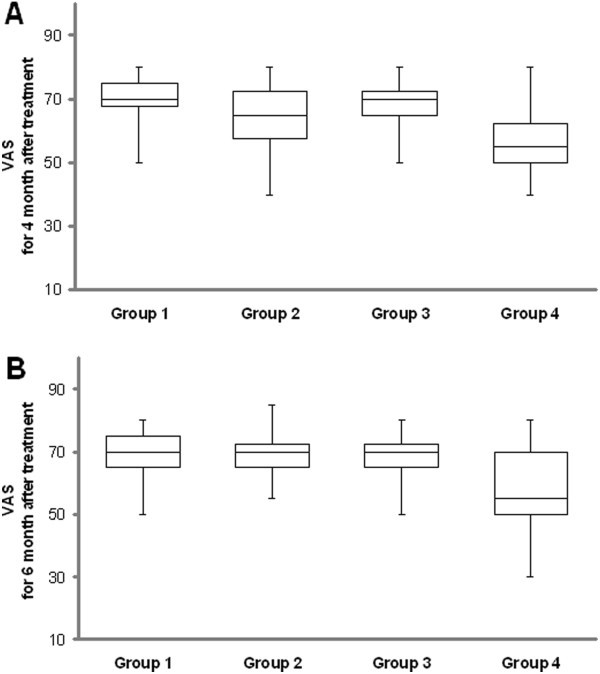
An illustration of all groups, the distribution of values for visual analogue scale (VAS) for (A) 4 month after treatment and (B) 6 months after treatment.